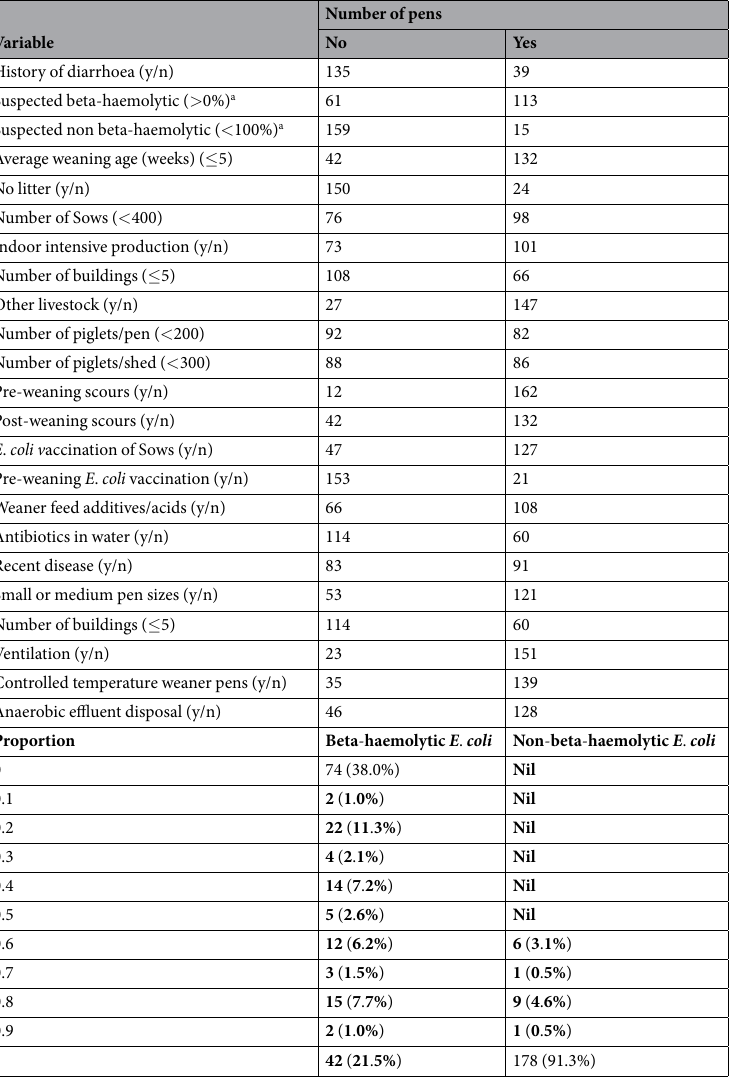
Table 1. Data from a questionnaire survey of 17 farms and sampling of 174 pens of piglets used as inputs to an additive Bayesian network following filtering of variables for missing data or significant associations with diarrhoea, pre- or post-scours. The two variables included in the model were: 1. beta haemolytic E . coli ( > 0%); and 2. non-beta haemolytic E . coli ( < 100%). These variables reflect the ‘unusual’ occurrence, as indicated by the bolding above. In the case of non-beta haemolytic E . coli , detection was near ubiquitous (91% positive). For beta-haemolytic E . coli the distribution was more complex, but polarised towards all (21.5%) or none (38%). Therefore rather than categorising beta-haemolytic E . coli based on 50% presence it was partitioned as some/ none with none used as the reference category i.e. the odds of at least some beta-haemolytic E. coli present in the pen. a E . coli detections were modelled based on the number of pens with a given proportion of 1. beta- haemolytic E . coli and 2. non-beta haemolytic E . coli , as follows (data shown is prior to application of filtering procedures which reduced the number of pens from 195 to